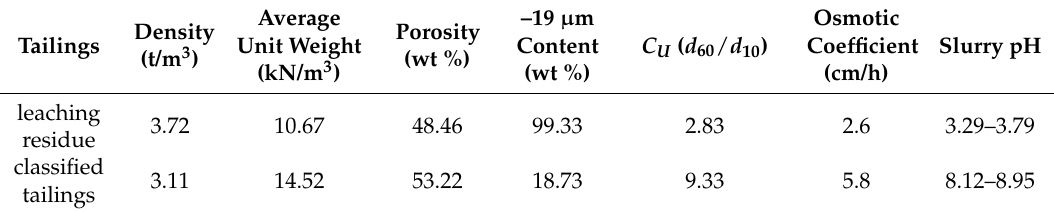
Table 1. Physical properties of leaching residue and classified tailings.